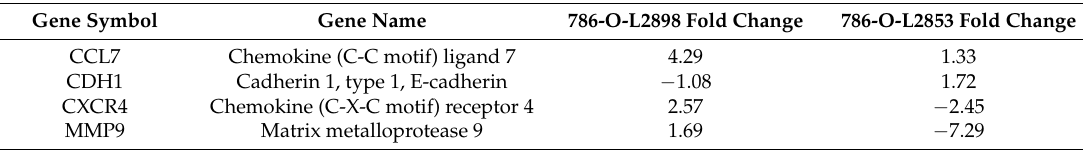
Figure 5. Effect of HAI-2 knockdown or engineered expression on motility and invasiveness of 786-O cells. Cell motility was evaluated by wound healing assay ( A ), and invasion assay ( B ) through Matigel with and without endogenous pro-HGF. Values are means ± standard deviation of triplicate experiments. * p < 0.05, Mann–Whitney U test. Table 1. Expression of molecules related to cancer metastasis in 786-O-L2898 and 786-O-L2853 cells, identified by RT 2 Profiler PCR Array